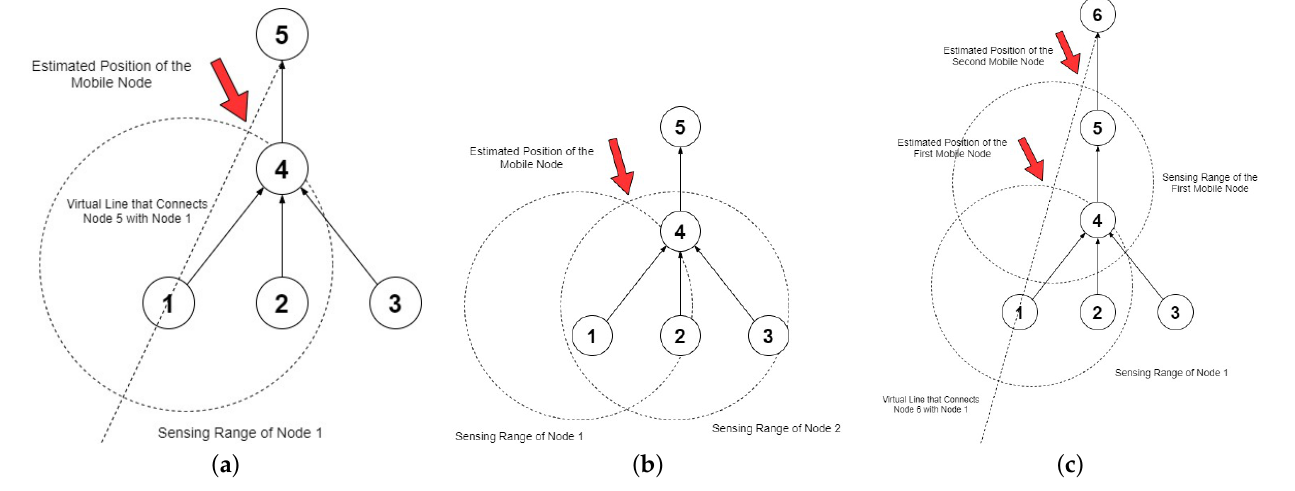
Figure 2. Node Placement Positions [8]. ( a ) Single Node, ( b ) Multiple Node, ( c ) Direct